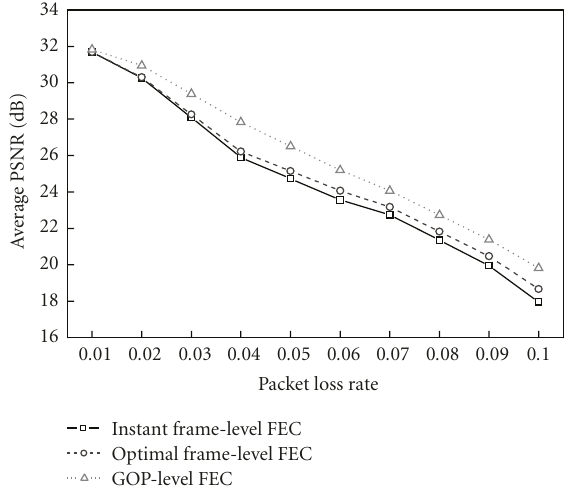
Figure 14: PSNR comparison with varied packet loss